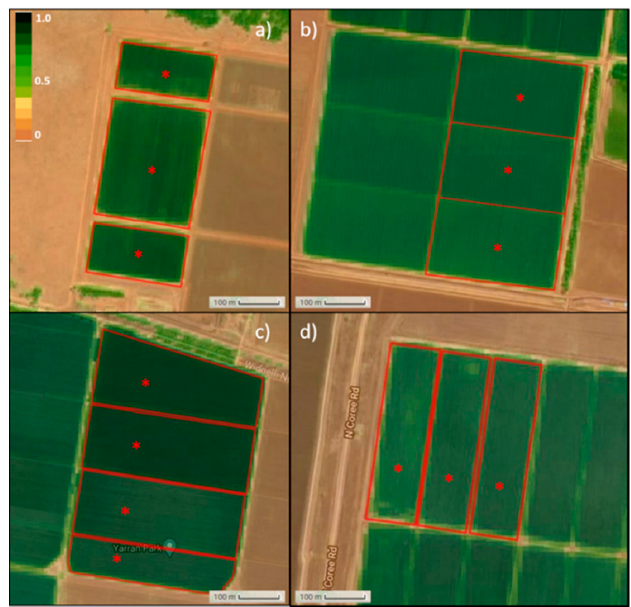
Figure 2. Sentinel-2 normalized difference vegetation index (NDVI) image (obtained from IrriSat [42] ) of the cotton ( a , b ) and rice farms ( c , d ) with detail of the bays monitored (red polygons) and location of the sensors (red asterisks) at each site.